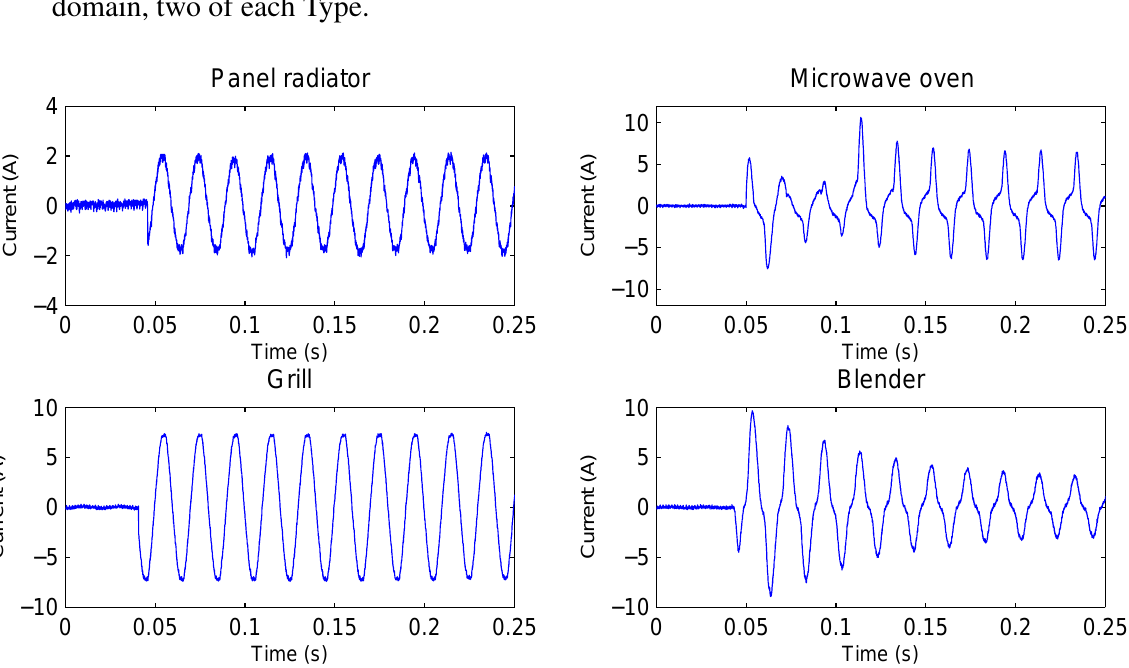
Figure 2. An example of the transient current signal for four different loads in the temporal domain, two of each